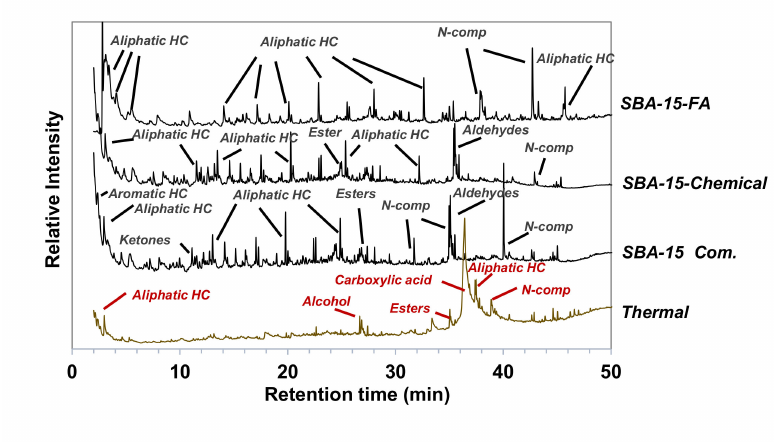
Figure 9. Py-GC / MS chromatograms of SI pyrolysis products over SBA-15 catalysts at 500 ◦ C with a SI / SBA-15 ratio of